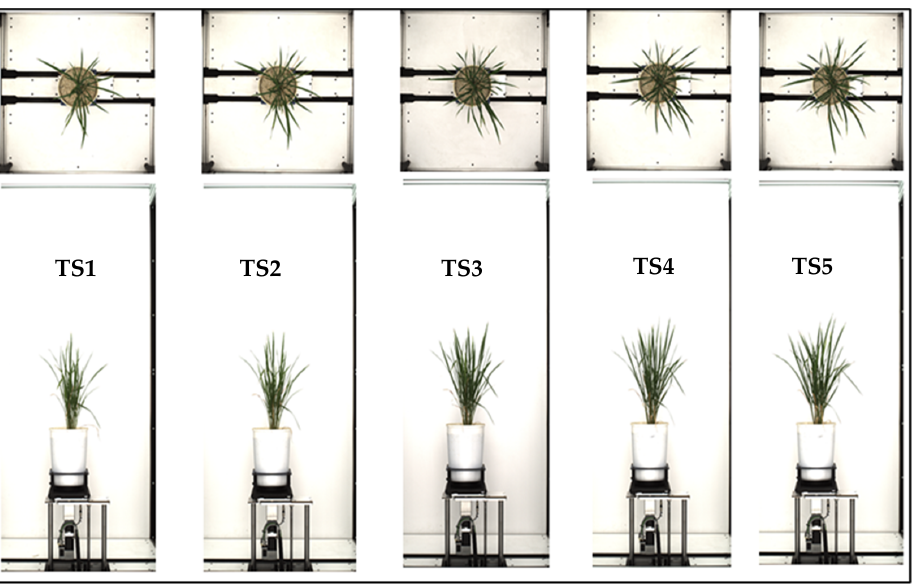
Figure 2. Rice plants images: side view (SV) and top view (TV) at different growth stages; TS—time snap, after inducing drought stress. TS-4 is the peak drought stress, and TS5 is after rewatering of the plants.